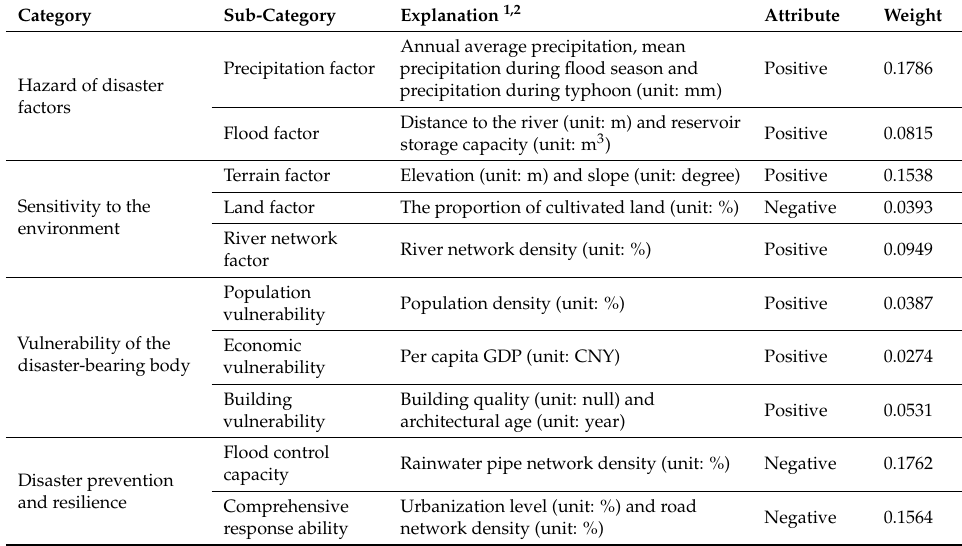
Table 1. Index system for evaluating the flood disaster risk of